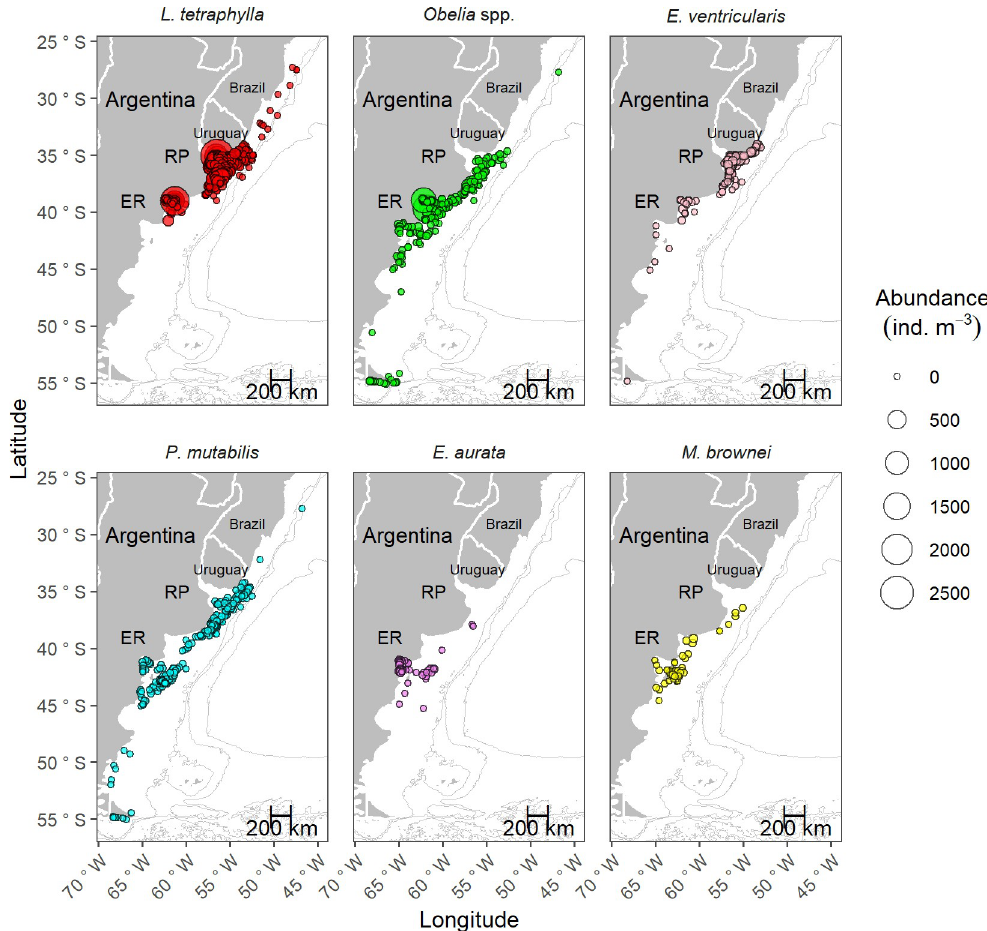
Fig 4. Spatial distribution of the abundance (ind. m-3) of the six most abundant hydromedusan taxa/species analyzed (in descending order of abundance: Liriope tetraphylla, Obelia spp., Eucheilota ventricularis, roboscydactila mutabilis, Euphysa aurata, and Mitrocomella brownei) along the SWA (27˚-56˚S) from 1983 to 2014. Data is shown in a continuous scale (min. value = 0.0017 ind. m-3, max. value = 2,474.49 ind. m-3). RP: Rı´o de la Plata, ER: El